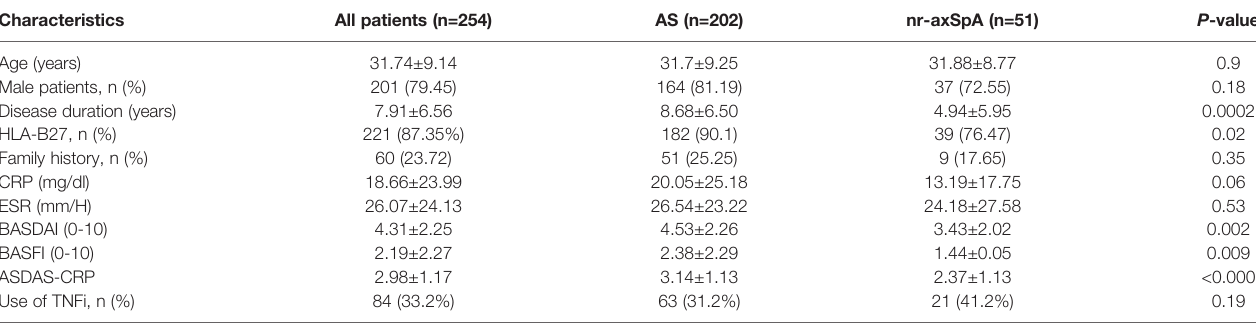
TABLE 1 | Demographic features of included